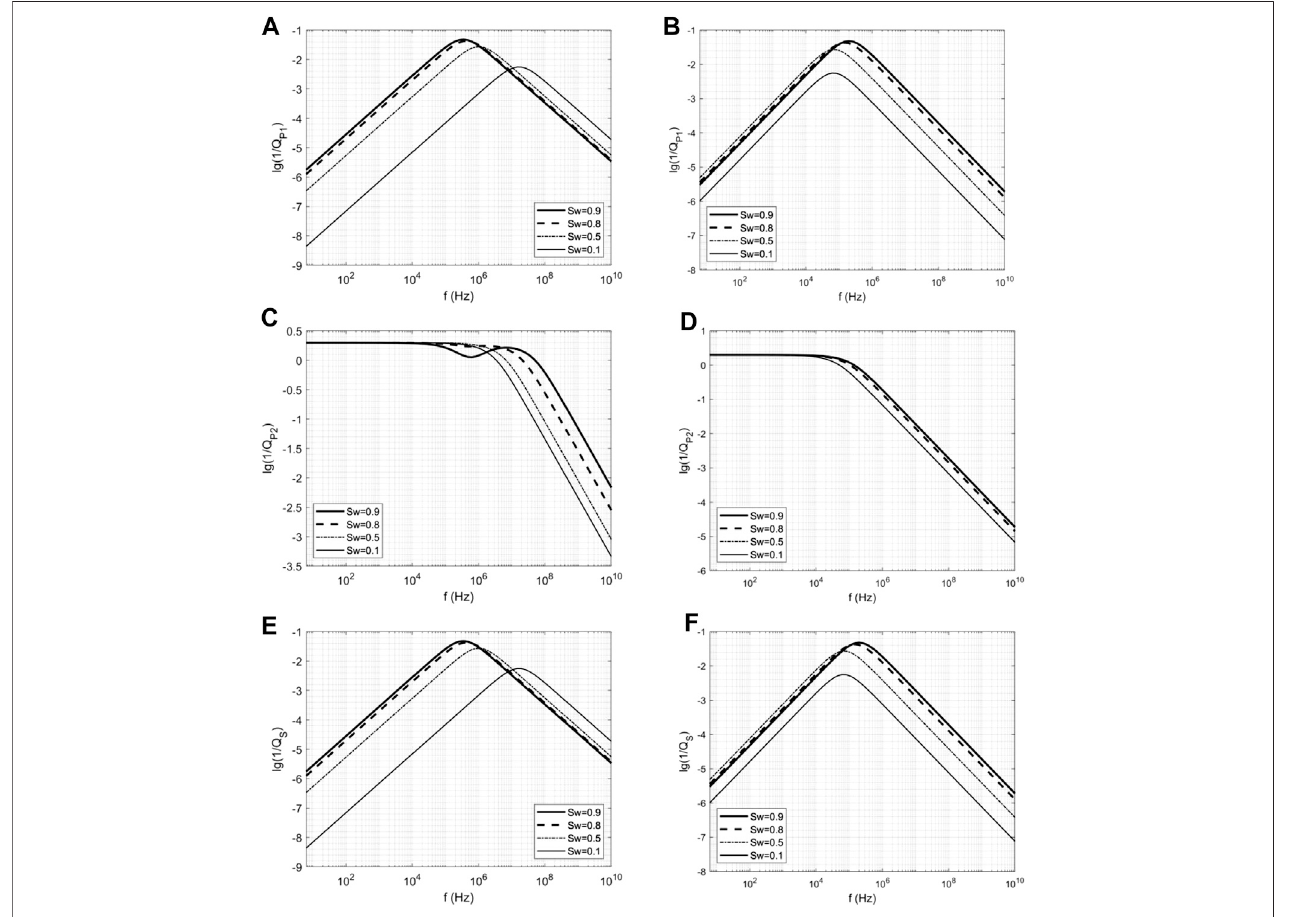
FIGURE 2 | The attenuation curve of seismic wave propagation in the porous media containing gas and water: (A,C,E) are the attenuation curves of the fast P-wave, the slow P-wave and the S-wave corresponding to four saturations calculated by Eq. 1 , respectively; (B,D,F) are those of results by the improved model proposed in this